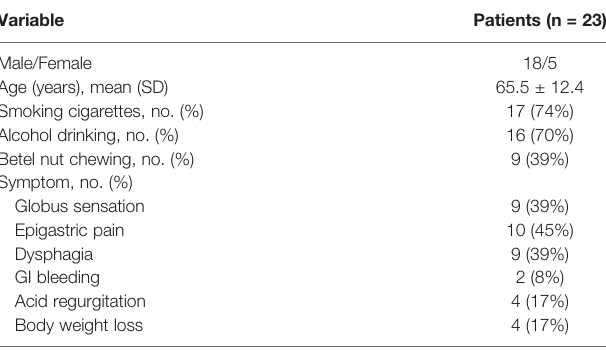
TABLE 1 | Characteristics of 23 patients with abnormal endoscopic fi ndings.